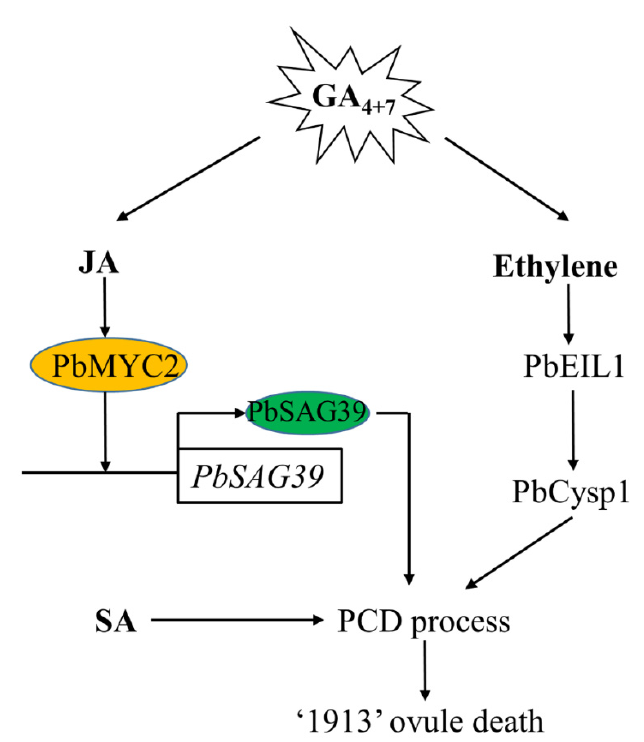
Figure 7. Model depicting the mechanism of GA 4+7 -induced seedless pear ovule abortion in advance. GA 4+7 treatment increases the production of JA and ethylene, and JA and ethylene signaling receptors PbMYC2 and PbEIL1 directly enhance their target genes PbSGA39 and PbCysp1 to regulate pear ovule abortion, respectively. SA also participates in the pear ovule PCD process. GA 4+7, Gibberellin A4 and A7; JA, Jasmonic Acid; SA, Salicylic acid; PCD, Programmed Cell Death. Supplementary Materials: The following are available online at